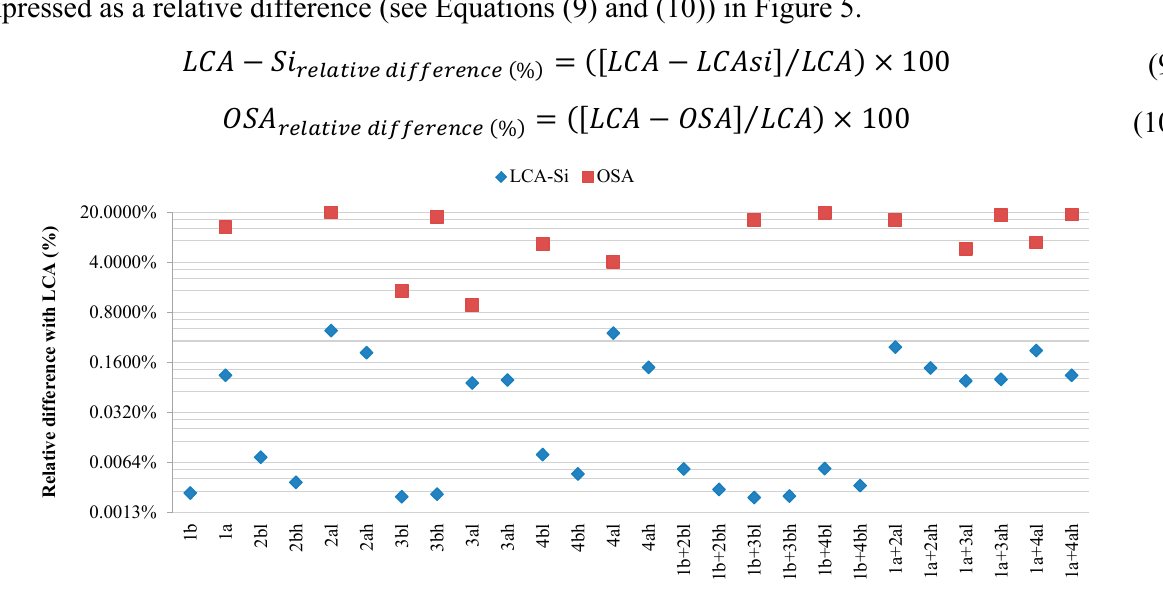
Figure 5. Relative difference of LCA-Si and OSA with